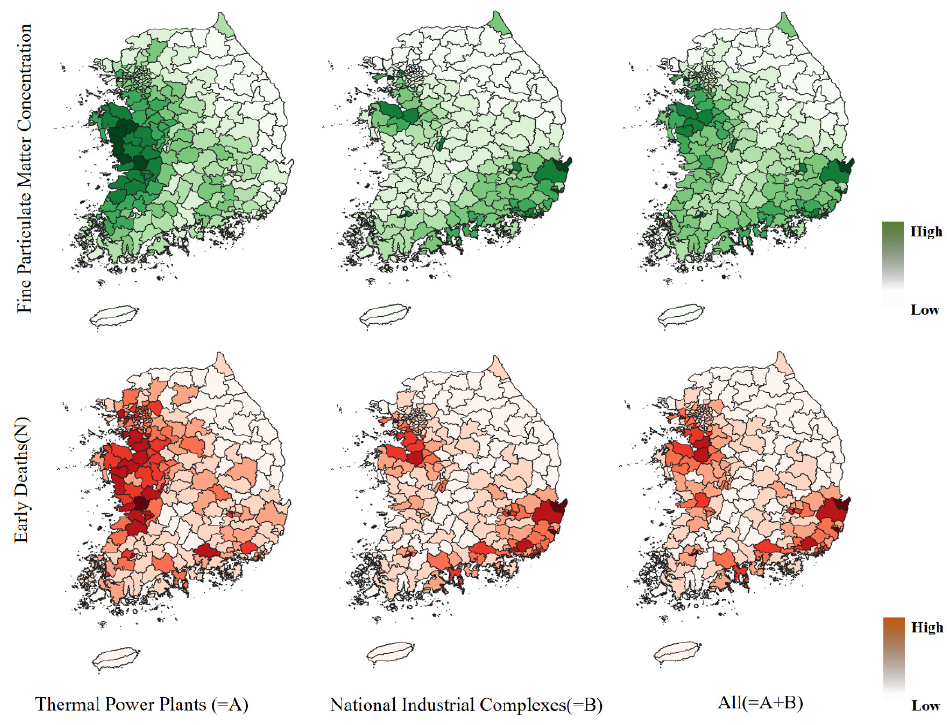
Figure 6. Changes in PM 2.5 concentration and early deaths.